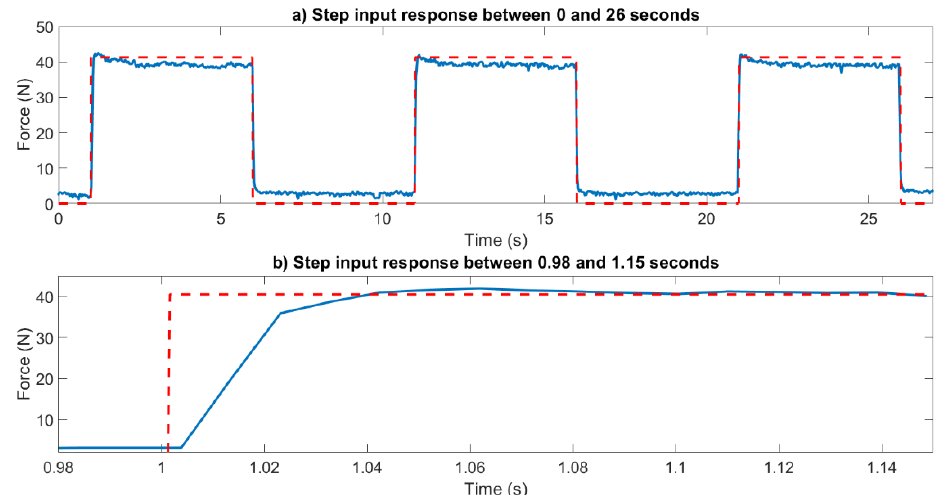
Figure 4. ( a ) Step input response between 0 and 26 s, ( b ) step input response between 0.98 and 1.15 s. The red line shows the input and the blue line shows the sensor response.